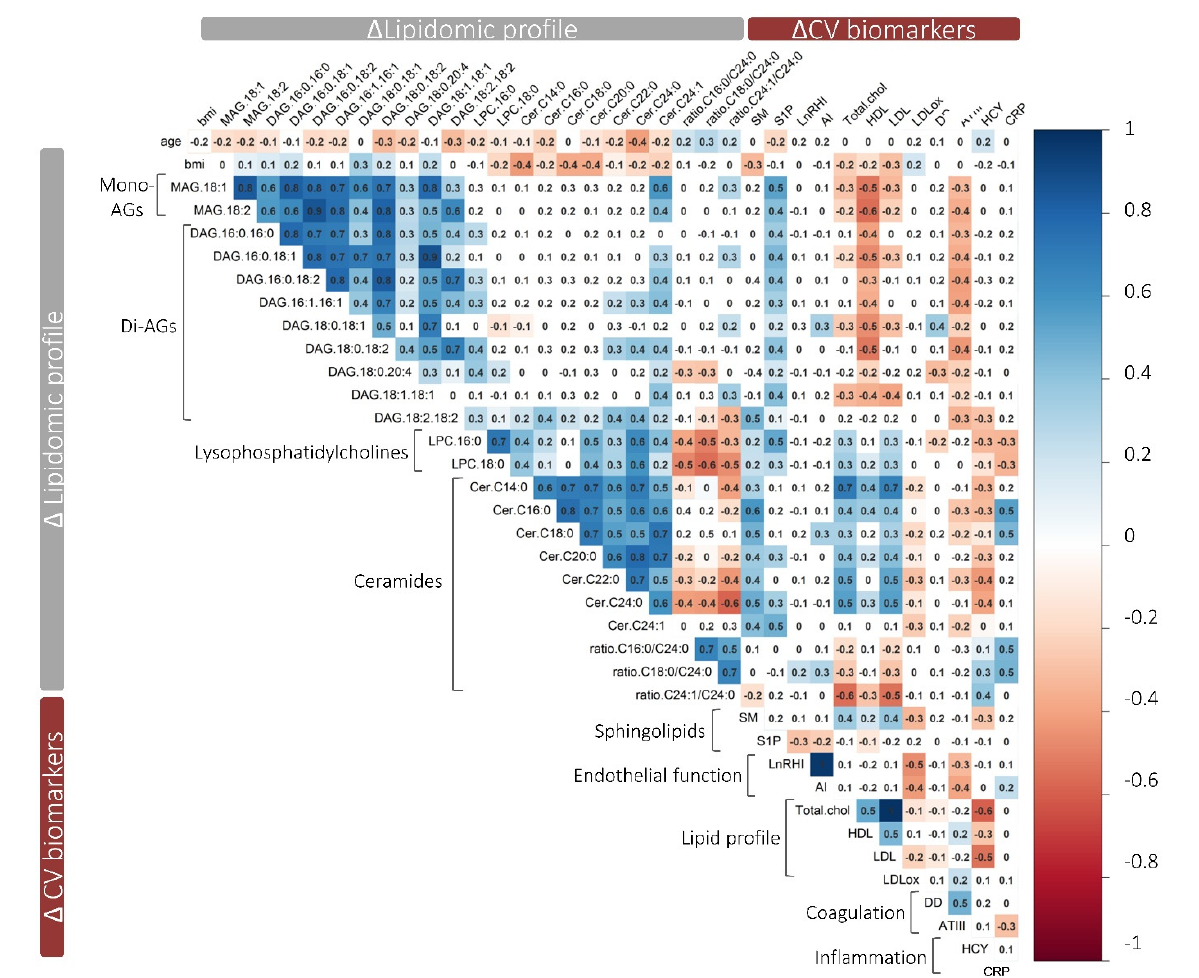
Figure 3. Correlation matrix of the changes observed in the lipidomic profile after WW + TYR intervention with the changes observed in CV biomarkers. Pearson’s correlation matrix of the ∆ of the lipidomic profile (final vs. baseline) with the ∆ observed in CV biomarkers ( n = 33) at the end of WW + TYR intervention. Blank squares represent correlations with a p -value > 0.05. Positive correlations are shown in blue and negative correlations are shown in red. Abbreviations: AGs, acylglycerols, CV, cardiovascular, SM, sphingomyelin; S1P, sphingosine 1 phosphate. LnRHI, logarithm of reactive hyperemia index; AI, augmentation index; Total chol, total cholesterol; DD, D-dimer; HCY, homocysteine; CRP, C-reactive protein.